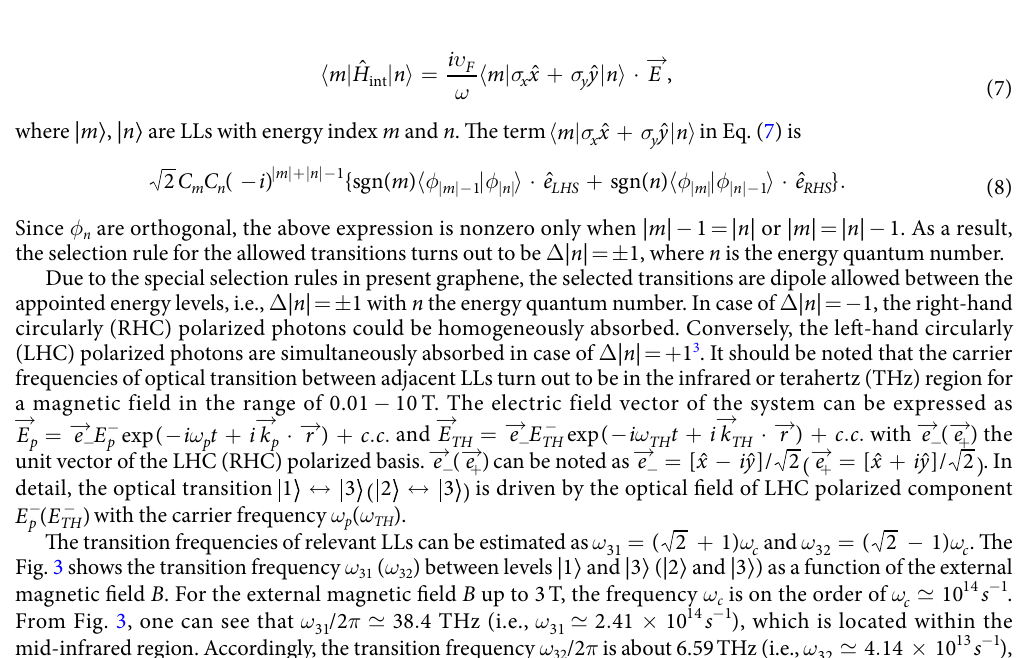
Figure 3. The transition frequencies in the three-level graphene system shown in Fig. 1(b). The transition frequency ω 31 ( ω 32 ) indicates the splitting gap between levels |1 〉 and |3 〉 (|2 〉 and |3 〉